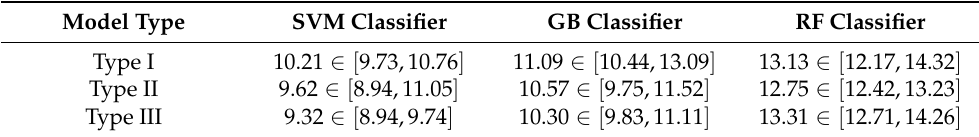
Figure 14. Accuracy of the Type I model: mean values and 95% confidence intervals. Table 6. Estimated time ˆ T of 95% predictability in years (mean values and 95% confidence